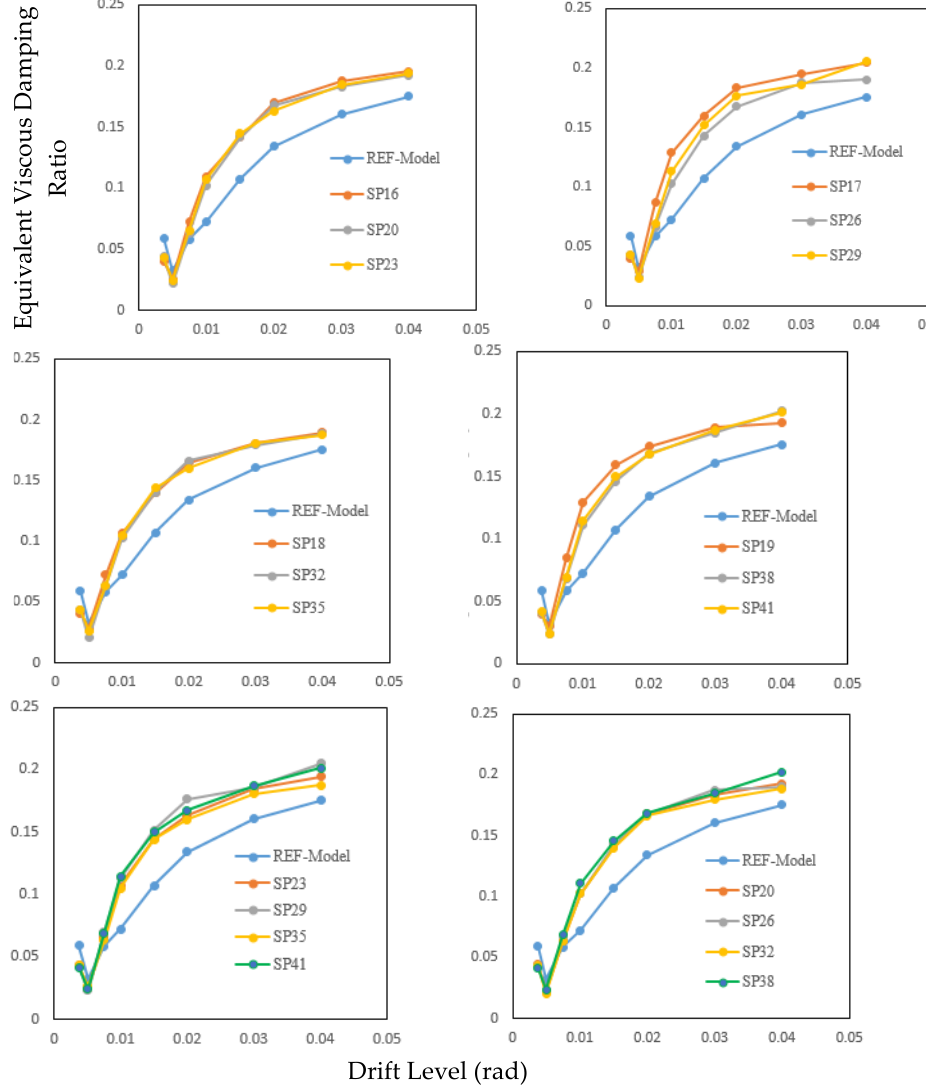
Figure 14. Illustration of total energy dissipation E D and maximum strain energy E So [119]. According to the EVDR/drift figures, the application of stiffeners affected the energy dissipation of the DST connections; EVDR increased up to 20% in a 4% drift. That showed a successful modified and developed edition of an original specimen (a stiffener-free model). Figure 15 shows the subsequent results on the EVDR versus drift level for all stiff- ened specimens.